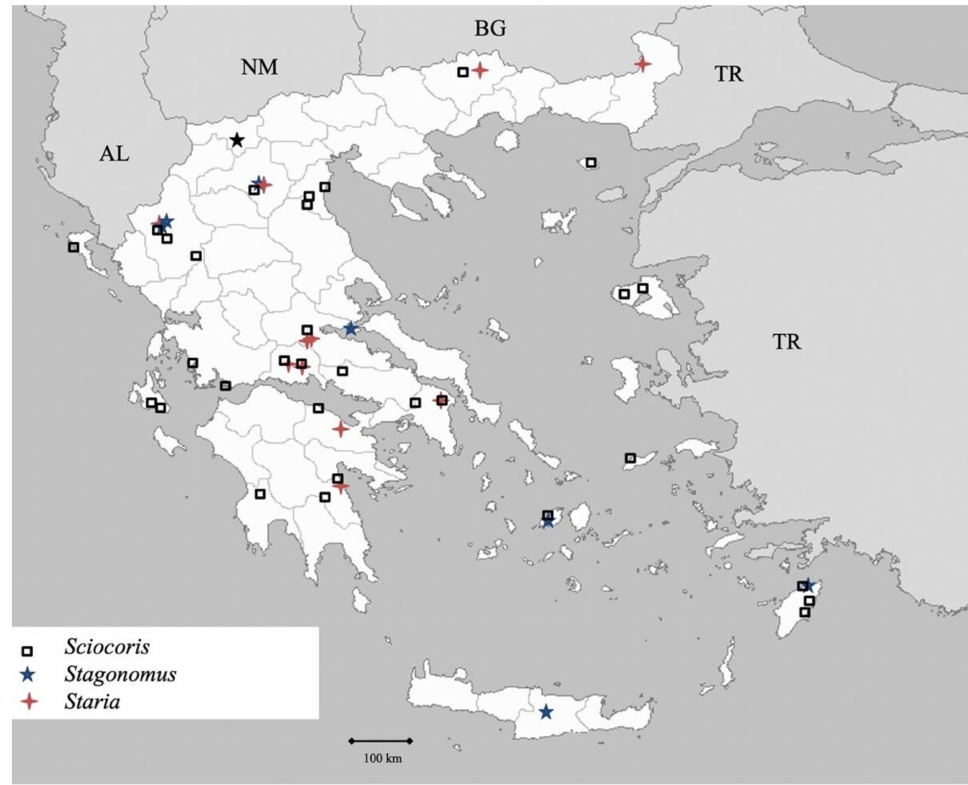
Figure 15. Map showing collecting sites of species of genera Sciocoris, Stagonomus and Staria during the present study in